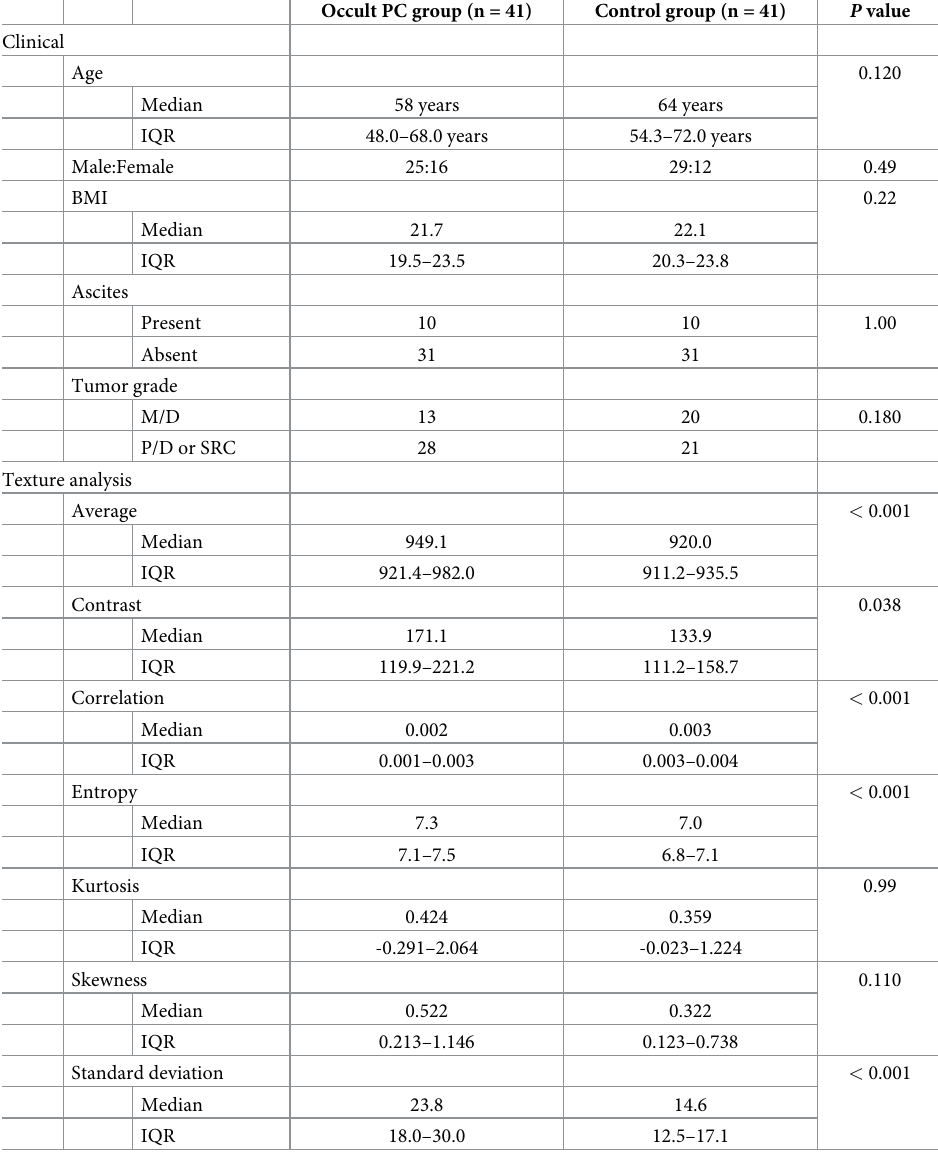
Table 1. Univariate analysis of clinical and texture characteristics in patients with and without occult PC.